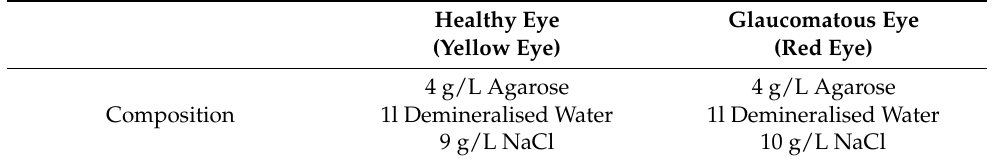
Table 2. Definition of phantom characteristics.